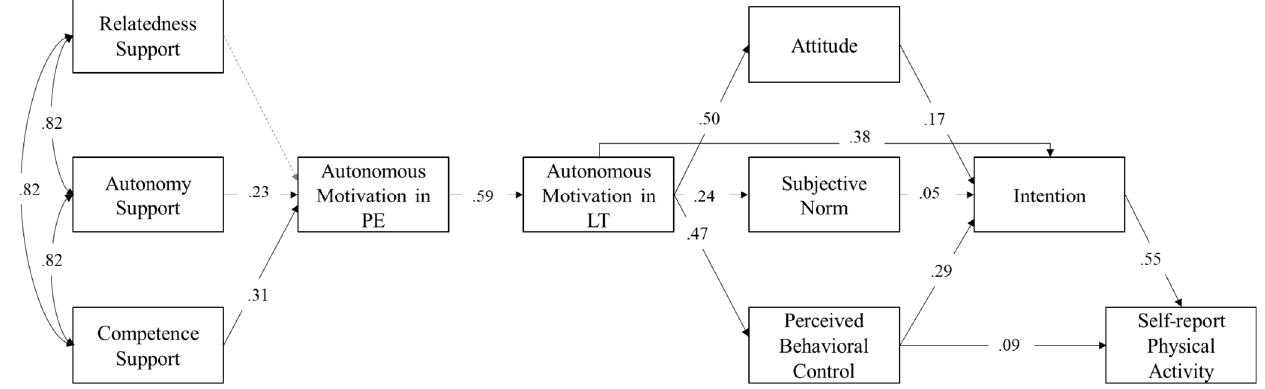
Figure 1. Path model (Model 1a) of the trans-contextual model. Model comprised a sample size of N = 1877 students. All calculated and standardized estimation paths are presented. Significant paths are depicted by solid arrows ( p < .05), while non-significant paths are represented by dashed arrows ( p > .05). PE = Physical education context; LT = Leisure time context.